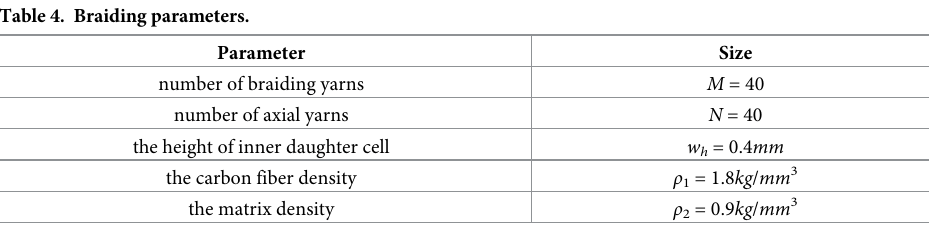
Table 4. Braiding parameters.